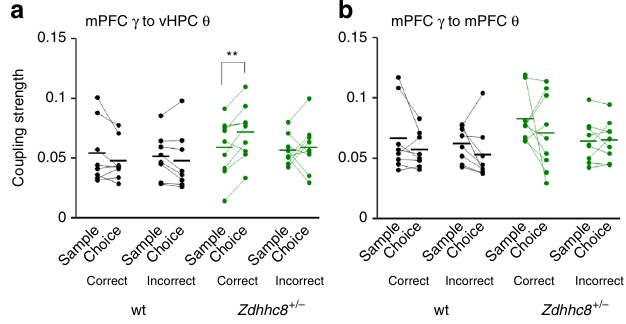
Fig. 4 vHPC theta – mPFC slow gamma coupling in Zdhhc8 + / − mice is enhanced with successful task execution of spatial working memory. a Strength of theta – slow gamma coupling in sample and choice phases in correct and incorrect trials. Zdhhc8 + / − mice showed signi fi cantly stronger coupling in choice than sample phases of correct trials but not incorrect trials, whereas wild-type mice showed equivalent coupling between sample and choice phases. (correct trials, wt; p = 0.17, Zdhhc8 + / − ; p = 0.0078, incorrect trials, wt; p = 0.26, Zdhhc8 + / − ; p = 0.71). ** p < 0.01; Paired t